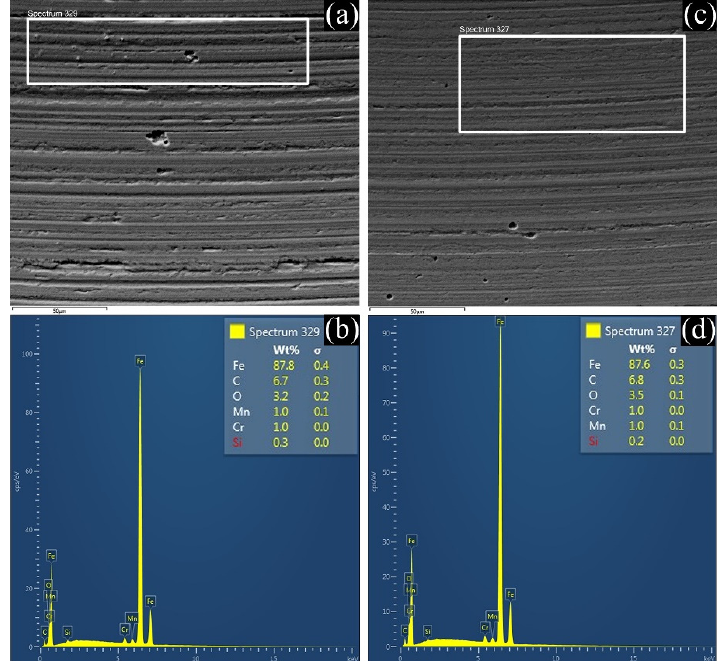
Figure 8. SEM and EDX analyses of steel surfaces tested with CO ( a , b ), and CO with astaxanthin ( c , d ).